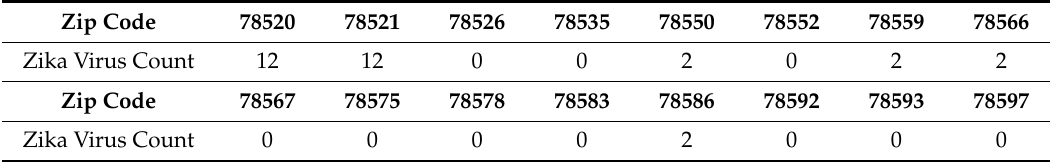
Table 1. Zika virus Count in 16 Zip Code in Cameron